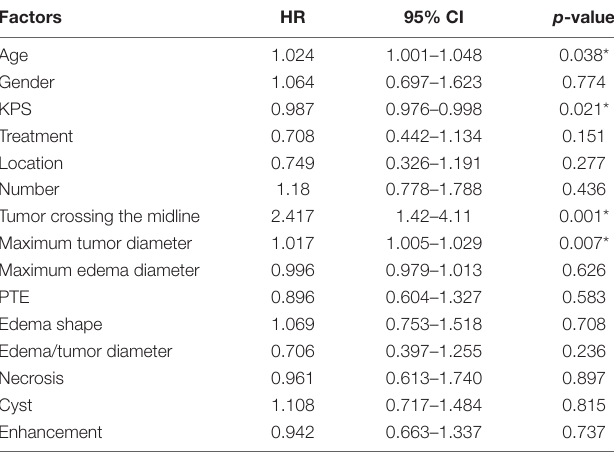
SPM. Then, the CE-T1WI, T2WI, and the T2-FLAIR images were preprocessed using Analysis Kit software (GE Healthcare, Chicago, IL, United States). This included bias correction, skull stripping, and image resampling and normalization. One radiologist (SW) used ITK-SNAP to manually segment the regions of interest (ROIs). The region with a high signal on the T2-FLAIR image was drawn as the ROI.